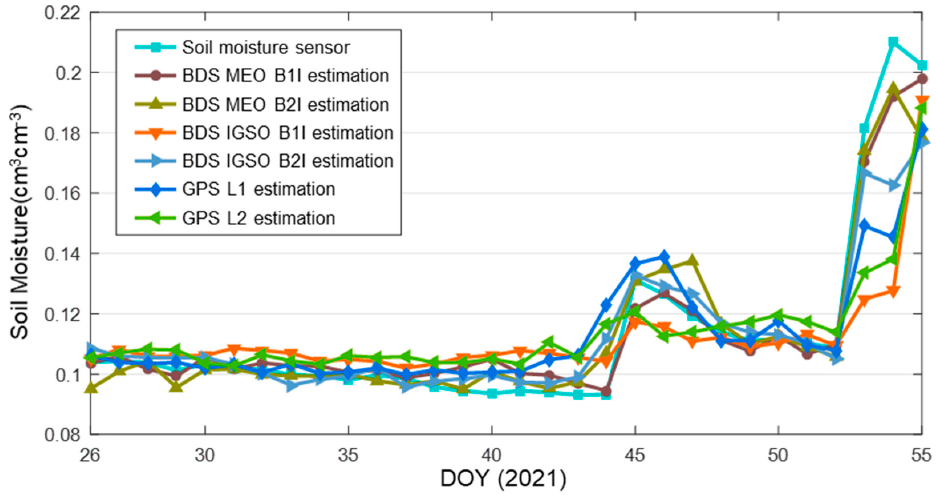
Figure 12. Multi-satellite soil moisture estimation results of BDS and GPS satellites.